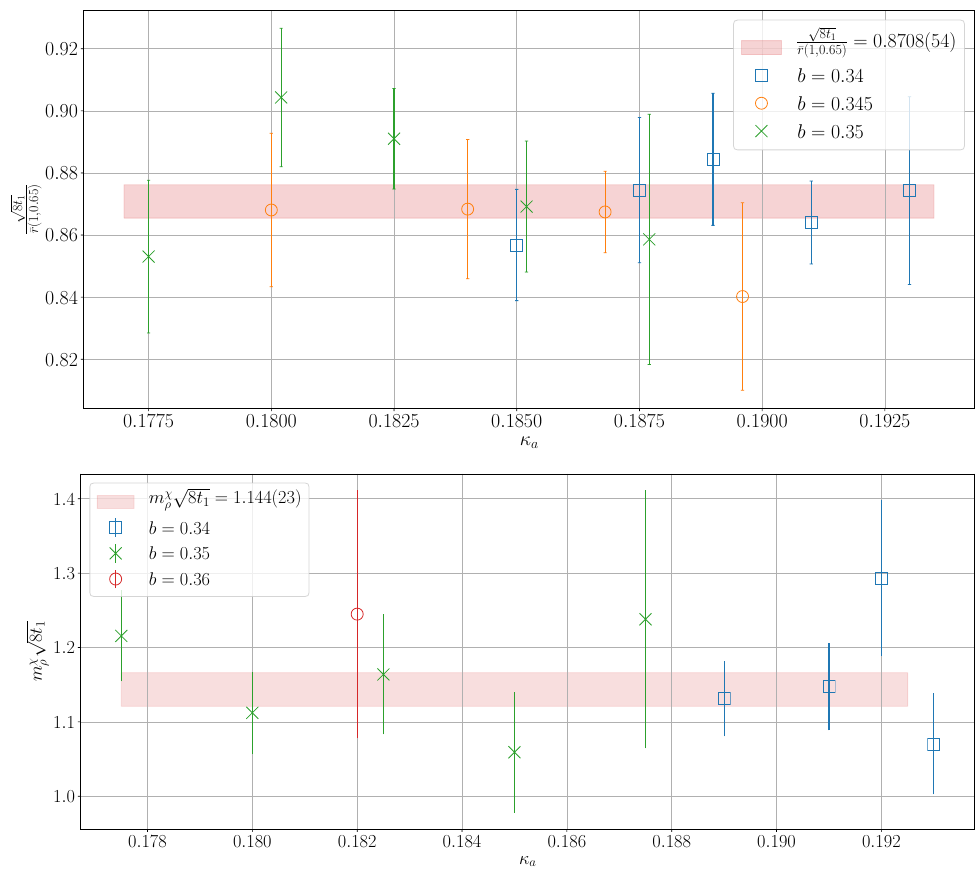
Figure 10. Comparison of scales as a function of the adjoint hopping parameter κ gauge couplings. In the top panel it is displayed the ratio √ 8 t 1 / ¯ r (1 , 0 . 65) , in the bottom one √ 8 t m χ 1 . The red bands represent the average weighted over the errors, while their width represent ρ the statistical uncertainty over the average ratio. When needed, points corresponding to the same κ a have been slightly shifted in the x-axes to avoid